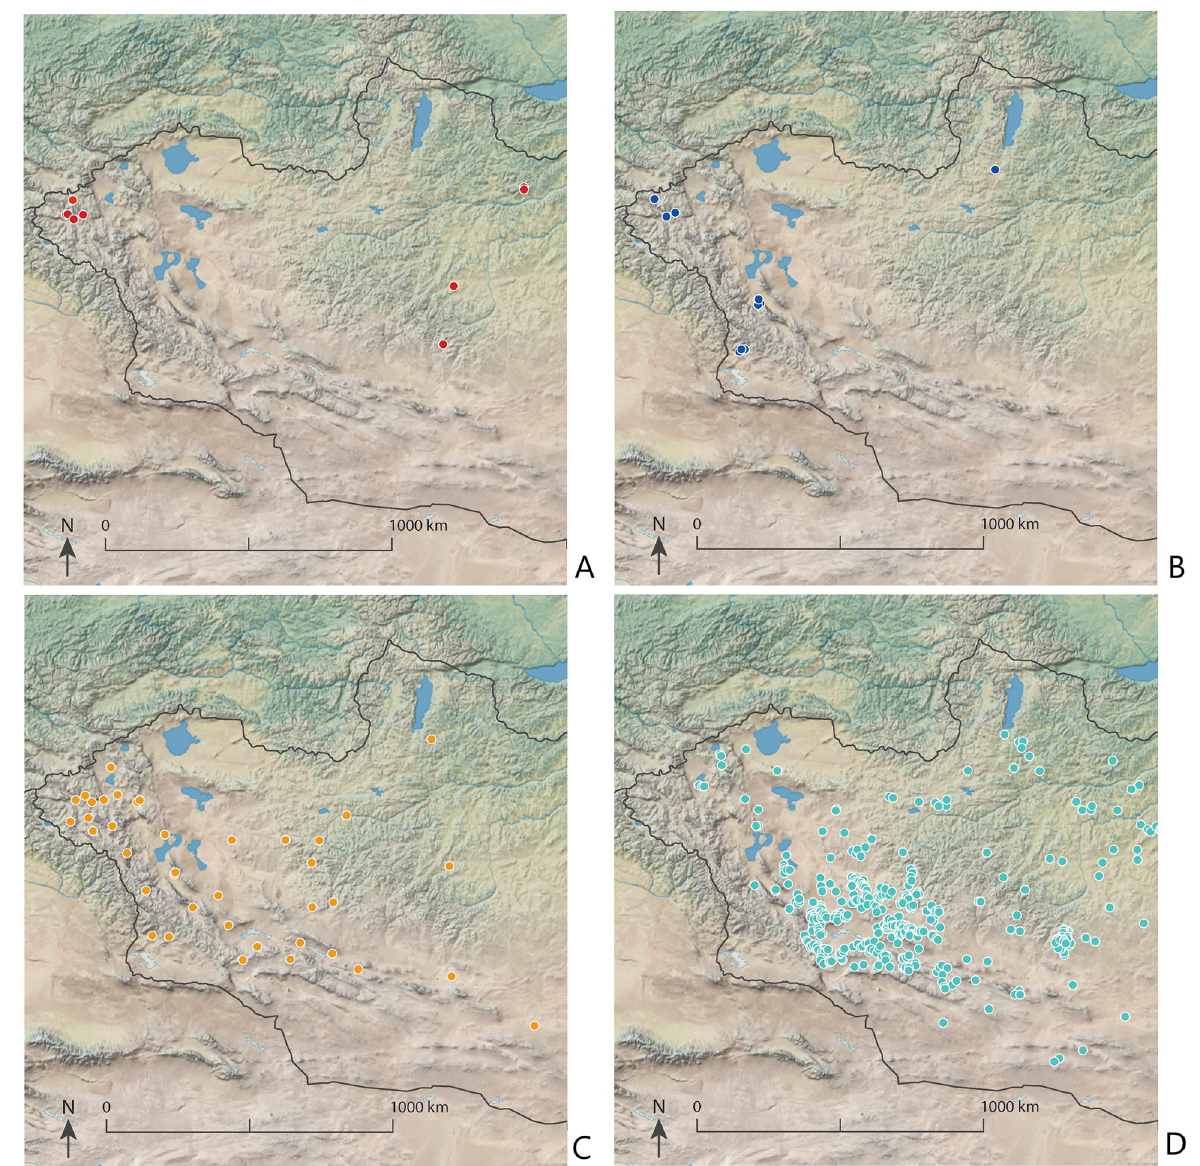
Fig 3. Archaeological sites identified in the Altai from the Early to Middle/Late Bronze Age point to a demographic increase beginning in the Middle Bronze Age (partially based on maps in [42]). These maps were produced using Adobe Illustrator CC 2020 and using the Natural Early Data maps from https://www.naturalearthdta.com/downloads/ by AVM and Michelle O’Reilly (Graphic Designer for the MPI-SHH) and John Klausmeyer (Illustrator for the UMMAA). A) Early Bronze Age (Afanasievo); B) Early Bronze Age (Khemceg or Monkhkhairkhan); C) Middle Bronze Age (Sagsai); D) Middle/Late Bronze Age (Khirgisuur).